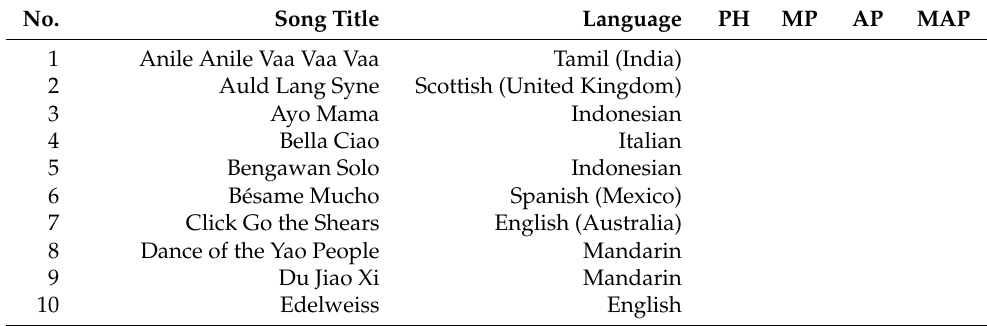
Table A2. Information (titles and languages) on the 53 songs which are not traditional Chinese anhemitonic pentatonic folk songs and whether their pitch distribution show a bell shape in various histograms. PH: pitch histogram; MP: merged pitch histogram; AP: anhemitonic pentatonic pitch histogram; MAP: merged anhemitonic pentatonic pitch histogram; (cid:88) : conforming to a perfect bell shape ( DoBell = 1). Note that the patterns of AP and MAP are judged only when the song is anhemitonic